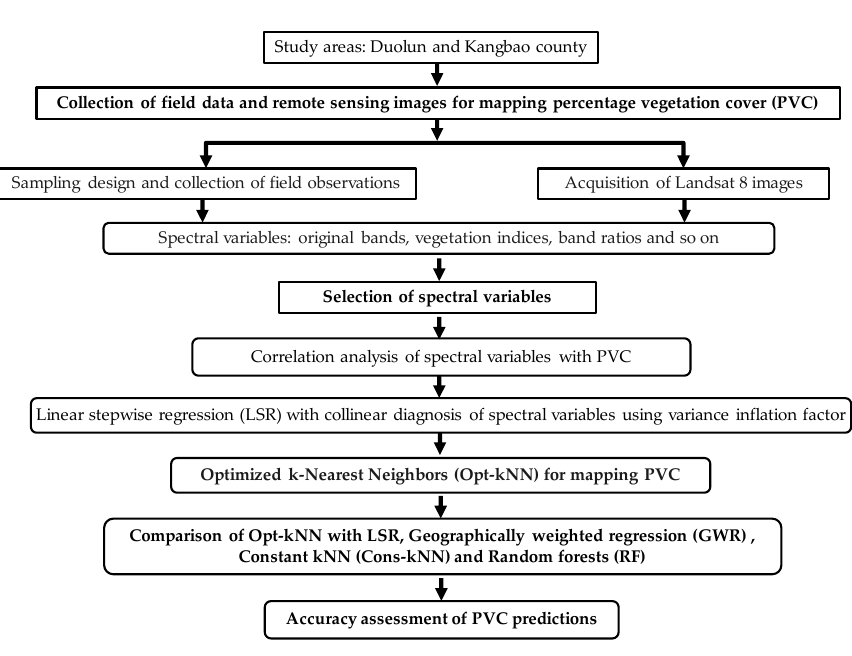
Figure 1. Methodological framework of this